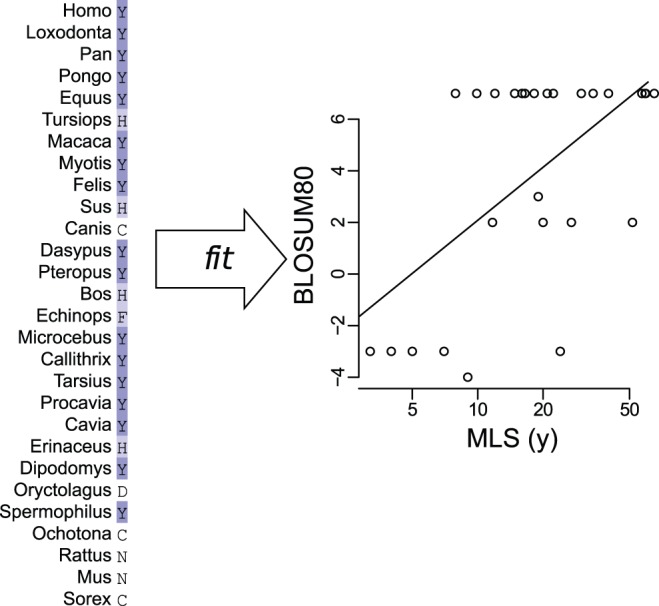
Conceptual example of our multiple regression method applied to a single column (Y465 of AMHR2; full result in Table S2).(left) Characters shown ordered by species MLS. For each non-human species, we calculate the similarity score (";BLOSUM80";) for the species’ amino acid character versus the human character (here Y); e.g., this score for Tursiops would be the similarity score for H versus Y, which is 2. (right) We then fit the MLS of all non-human species to their similarity scores; e.g., Tursiops’ contribution to this fit is the point (52, 2). Not shown are the steps to correct for mutation rate and shared phylogeny, and the simultaneous fit of body mass. For this column, the data provide relatively strong support for a nonzero slope in the fit of similarity to MLS, even given trends in mutation rate, phylogeny, and body mass, and so this position is assigned a relatively significant p-value (pMLS<0.01).